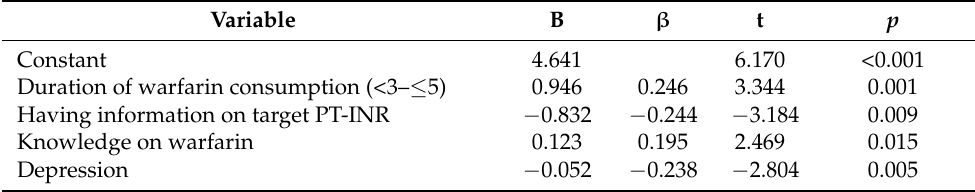
Table 5. Multiple regression analysis to identify the factors influencing medication adherence (n = 154). Variable B β t Constant